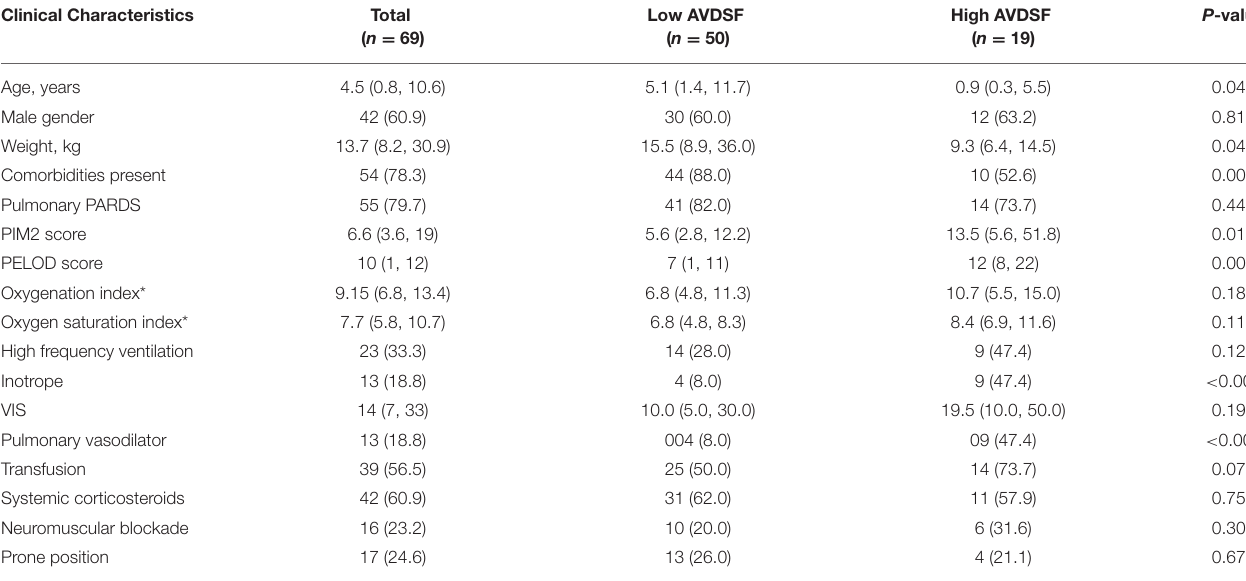
TABLE 1 | Clinical characteristic of pediatric acute respiratory distress syndrome patients across high and low AVDSF groups. Clinical